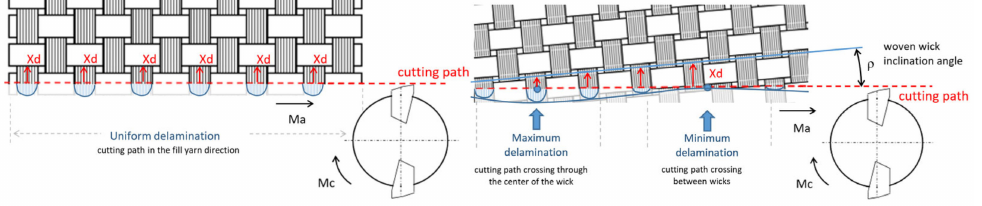
Figure 9. Xd variation.